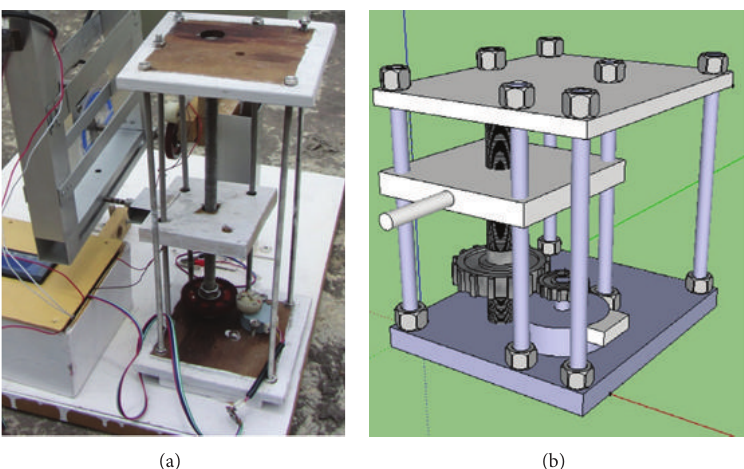
Figure 2: Design and implementation of linear actuator: (a) implementation and placement of linear actuator with the aluminium body of panel carrier; (b) hardware design of linear actuator in computer aided drafting